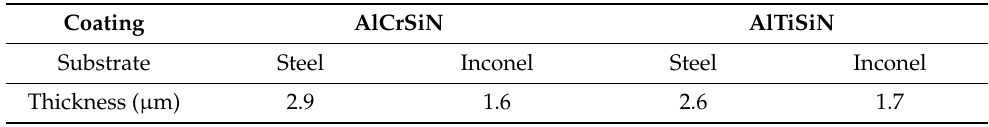
Table 4. Thickness of coated